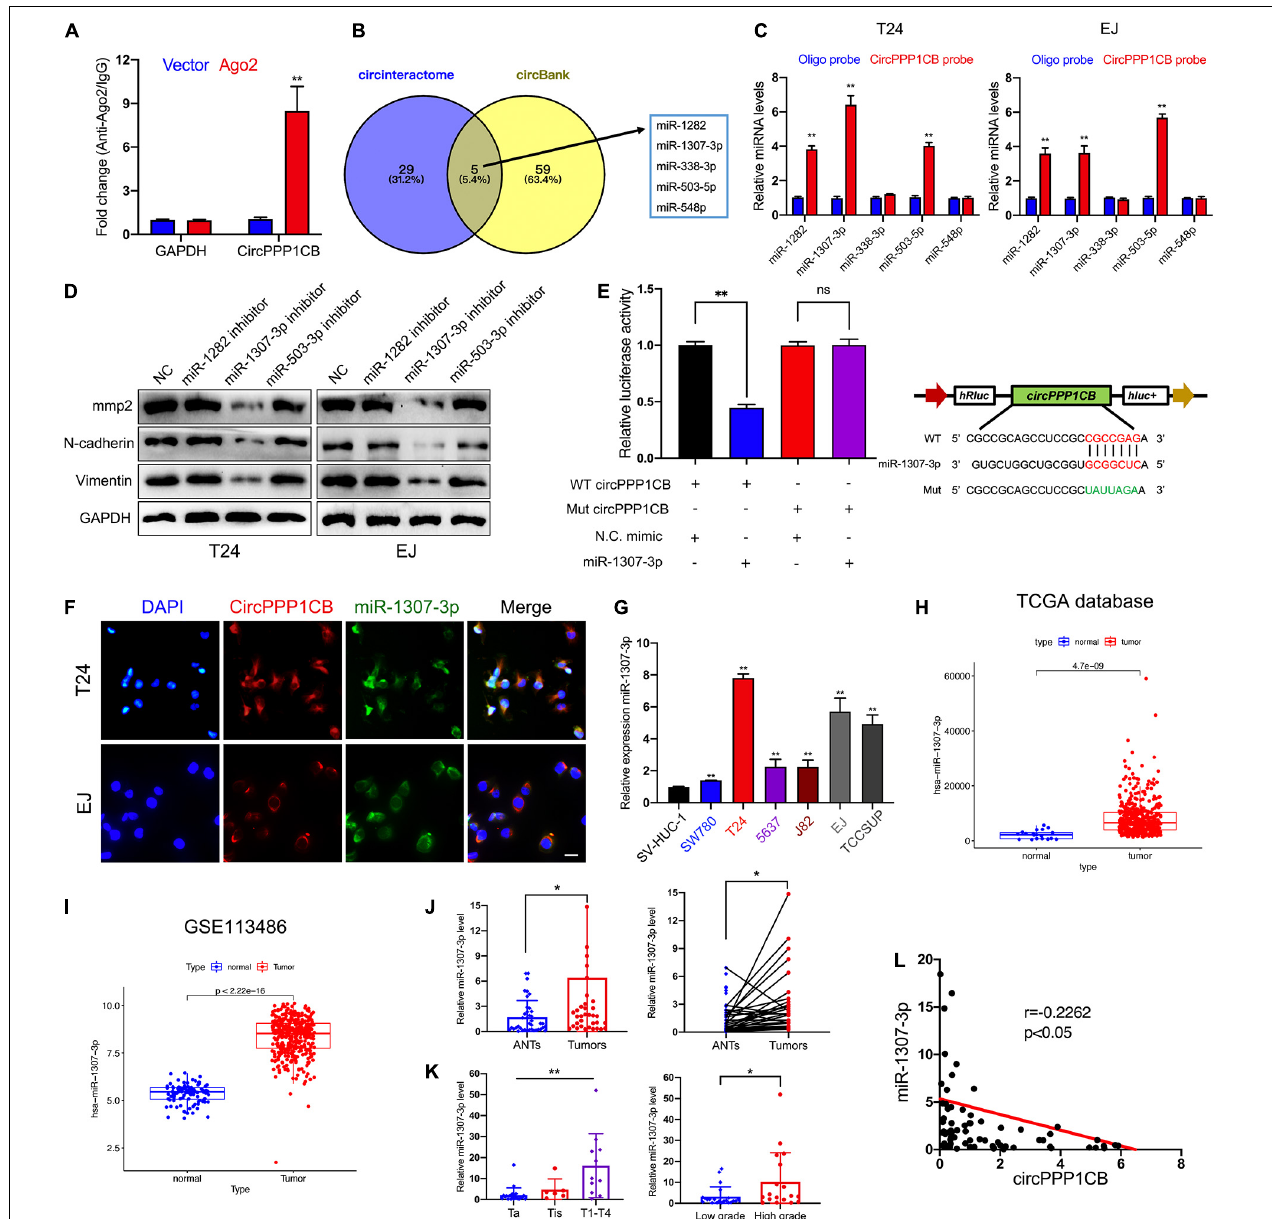
FIGURE 3 | CircPPP1CB sponges miR-1307-3p in bladder cancer cells. (A) RNA immunoprecipitation for circPPP1CB in HEK-293 cells transfected with Ago2 plasmids. (B) Overlapping of target miRNAs predicted in circinteractome and circBank was illustrated by a Venn diagram. (C) A specific probe for circPPP1CB was used to capture five predicted miRNAs in RNA pull-down assay. MiR-1282, miR-1307-3p, and miR-503-5p were captured in both T24 and EJ cells. (D) Levels of EMT markers and MMP2 were assessed in cells transfected with miRNA inhibitors or negative control by western blotting. (E) Relative luciferase activities in HEK-293 cells transfected with luc-circPPP1CB or luc-circPPP1CB-mutant with or without miR-1307-3p mimics were determined. Wild and mutant sequences of circPPP1CB were presented. (F) RNA FISH indicated that circPPP1CB and miR-1307-3p were colocalized in the cytoplasm. Scale bar, 100 µ m. (G) MiR-1307-3p levels were detected by qRT-PCR in SV-HUC-1 and six bladder cancer cell lines. (H,I) MiR-1307-3p was upregulated in bladder cancer in both TCGA database and GSE113486. (J) Dysregulation of miR-1307-3p in bladder cancer tissue compared with adjacent normal tissue was indicated in our own cohort ( n = 40)